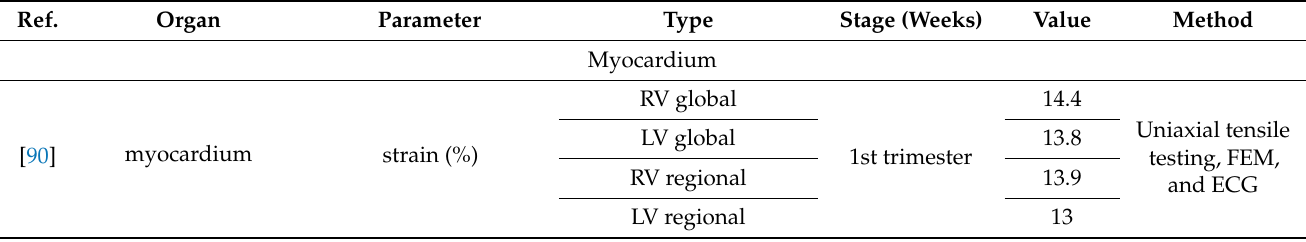
Table 5. Basic properties of human cardiovascular components at different gestational ages. Clinical measurement techniques and clinical image modalities are generally employed for data